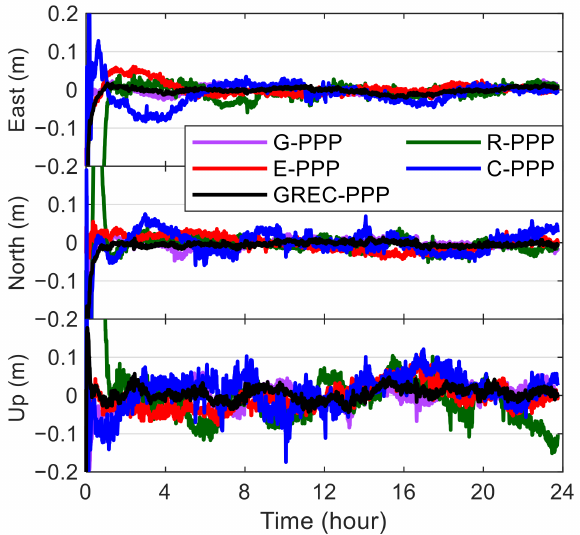
Figure 13. Epoch-wise position errors of kinematic PPP using CNES real-time precise products